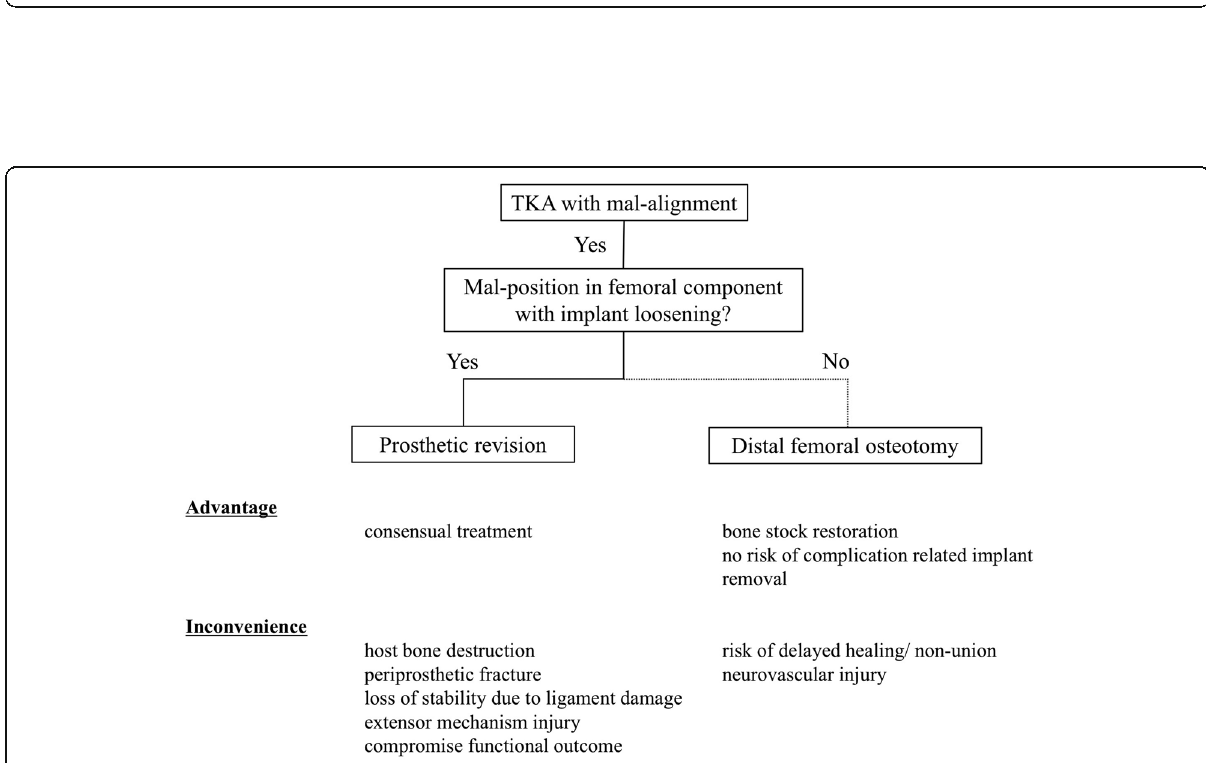
Fig. 6 X-rays at the final follow-up. a Normalized alignment of the left lower extremity. b Disappearance of the posterior tibial sag. c Patella reduced but patella tilt remained as much as 15 degrees